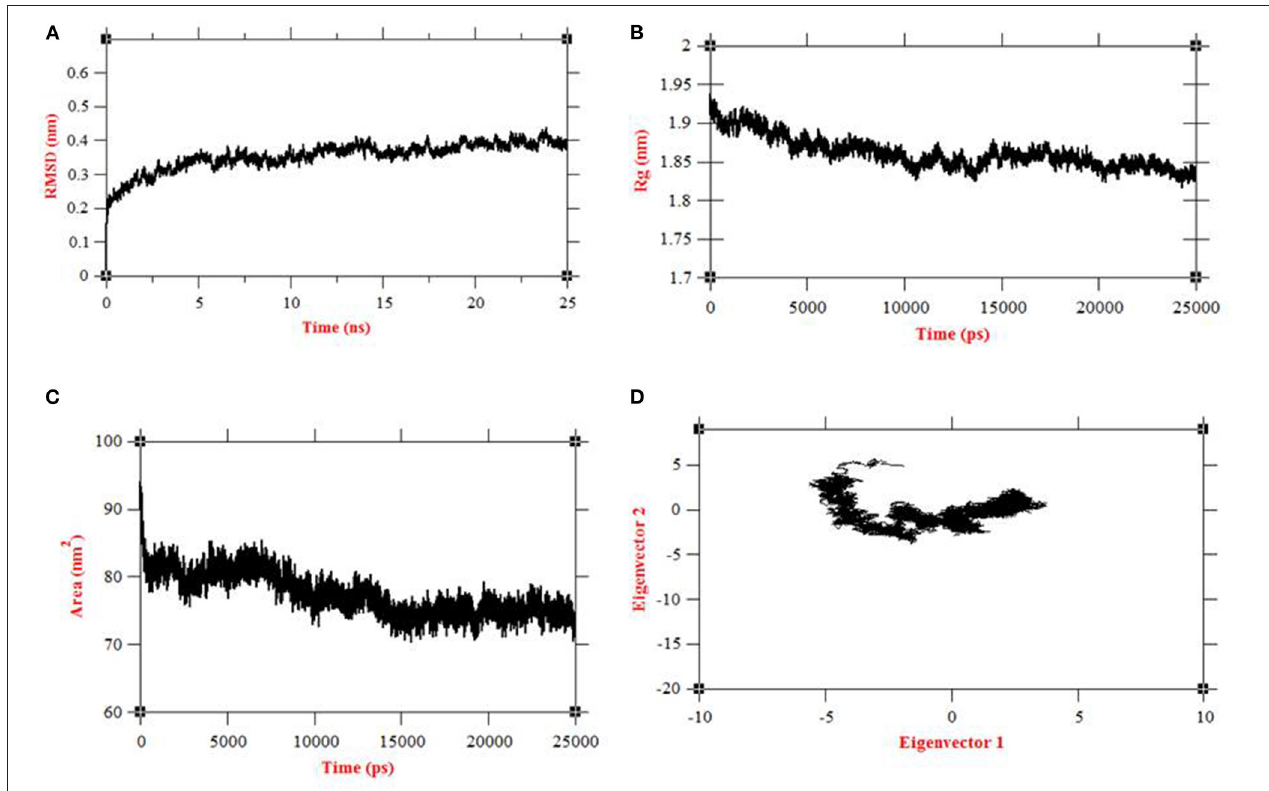
FIGURE 3 | Molecular dynamics simulations at 25ns of human septin 4 model (A) RMSD plot, (B) Rg plot, (C) SASA plot, (D) PCA